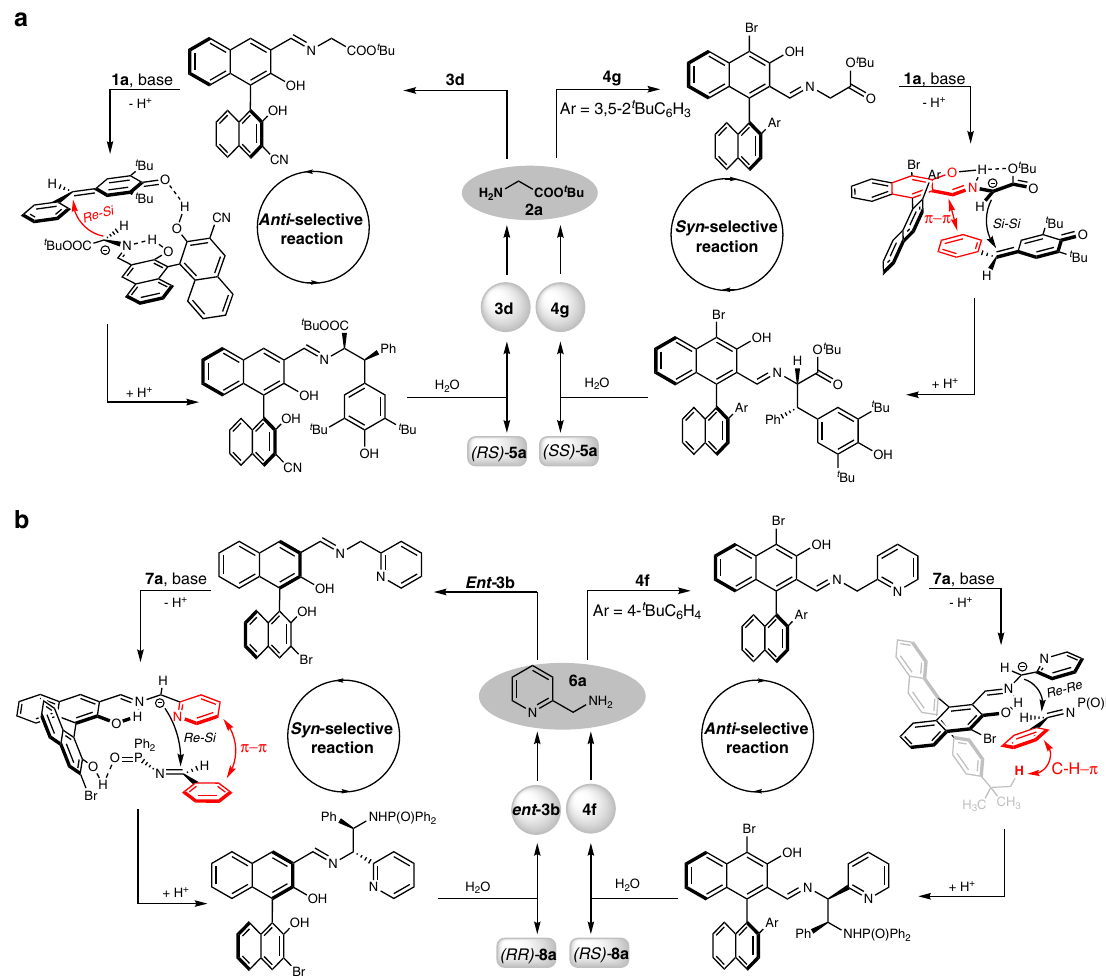
Fig. 6 Proposed catalytic cycles. a The proposed catalytic cycles for the anti- selective 1,6-conjugated addition reaction (left) and syn- selective one (right). b The proposed catalytic cycles for the syn- selective Mannich reaction (left) and anti- selective one